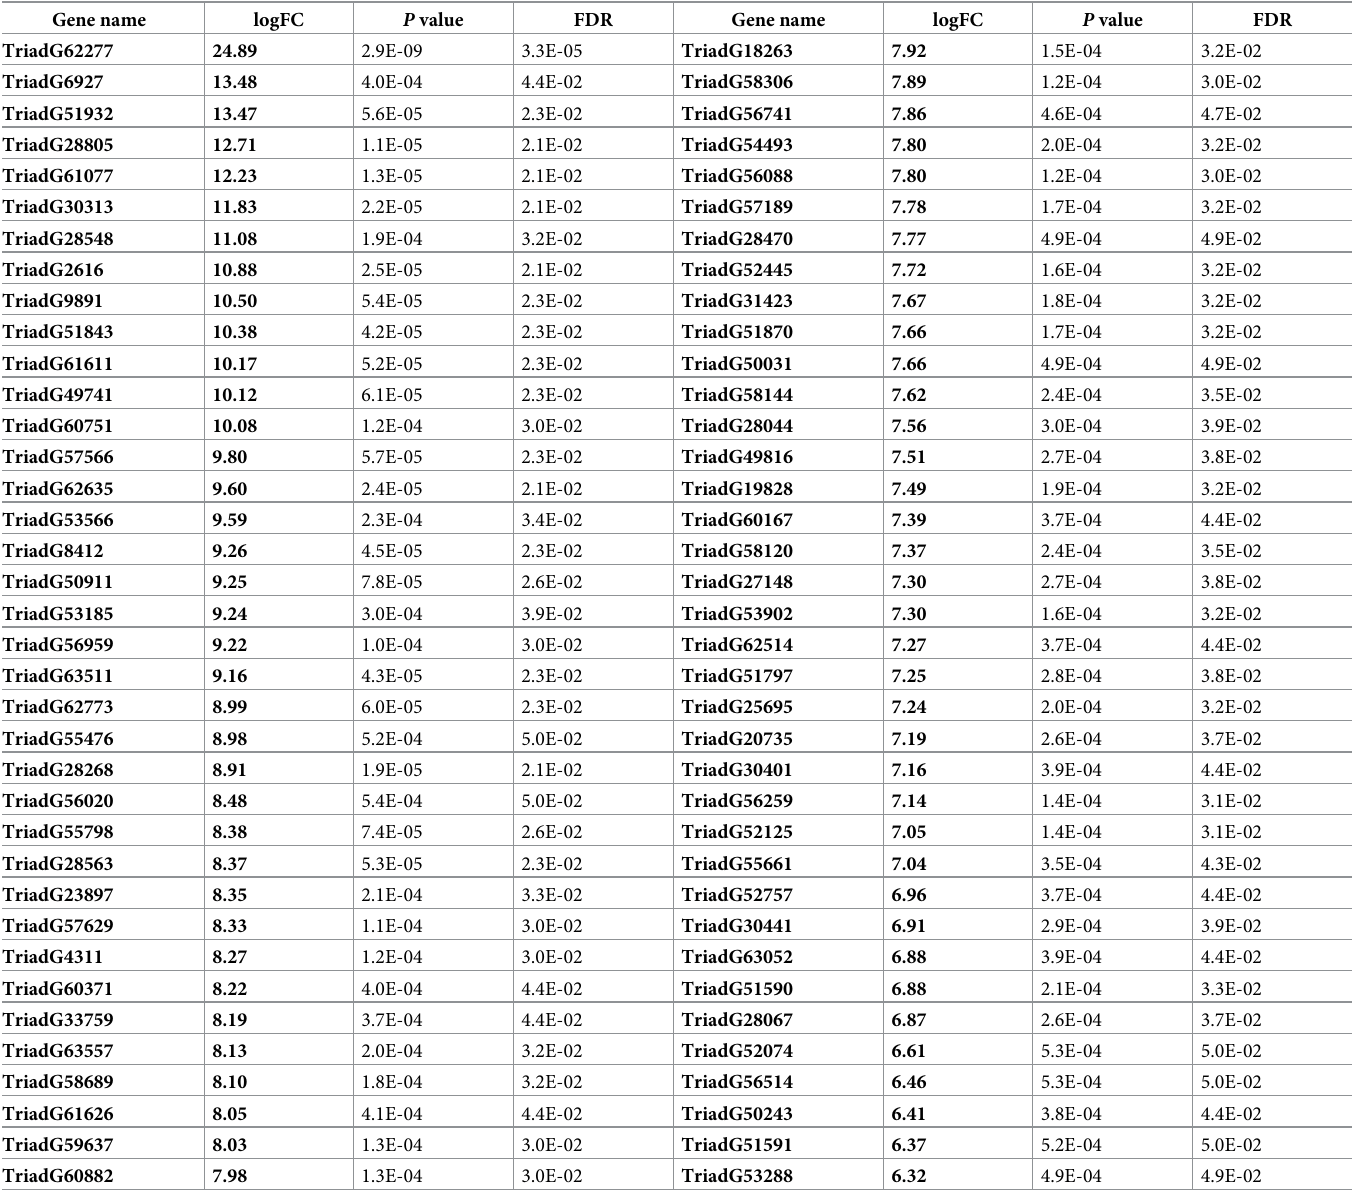
Table 1. Genes overexpressed after 2 hours following X-ray